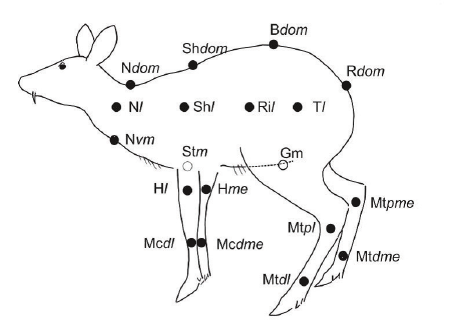
Figure 1. Depth of fur was measured to 1 mm at 23 dif- ferent locations on the body in musk deer and reindeer. Locations. Back: Sh dom , B dom , R dom ; Neck: N dm , N l , N vm ; Flank: Sh l , Ri l , T l ; Belly: St m , G m ; Leg: H l , H me , M cdl , Mc dme , Mt pl , Mt pme , Mt dl , Mt dme . B back, G groin, H humerus, Mc metacarpus, Mt meta- tarsus, N neck, R rump, Ri rib, Sh shoulder, St ster- num, T thigh; d distal; do , dorsal; l , lateral; m , midline; me , medial; p , proximal, v , ventral. N l , Sh l , Ri l and T l were measured on both left and right sides and both values for each site were included in the sample